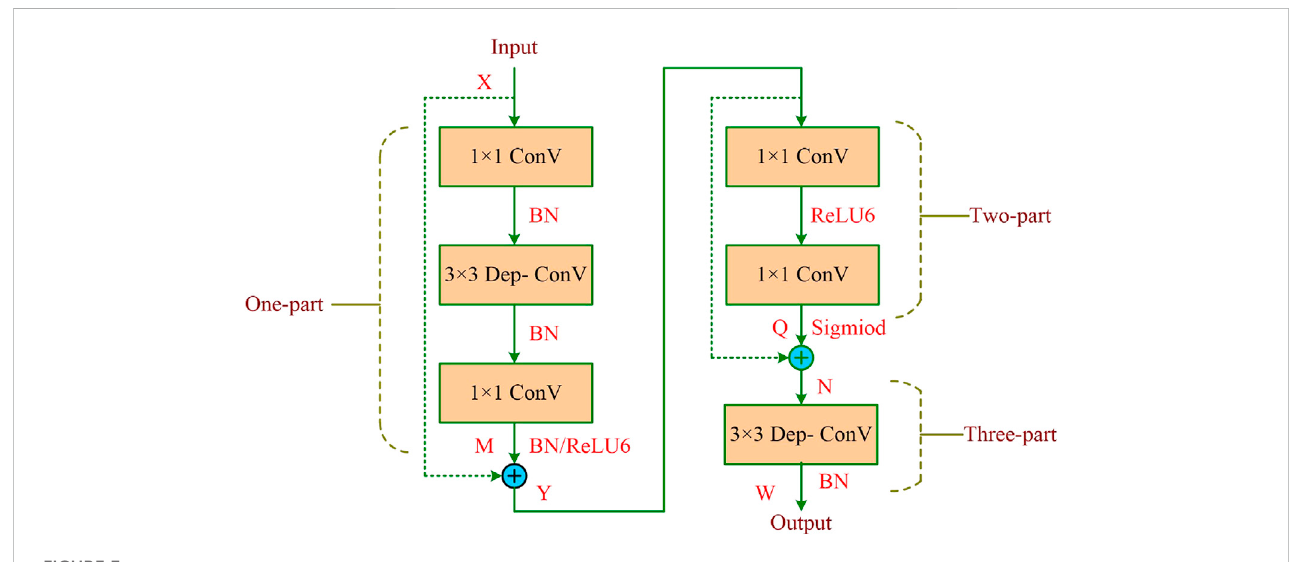
FIGURE 3 D-model module structure